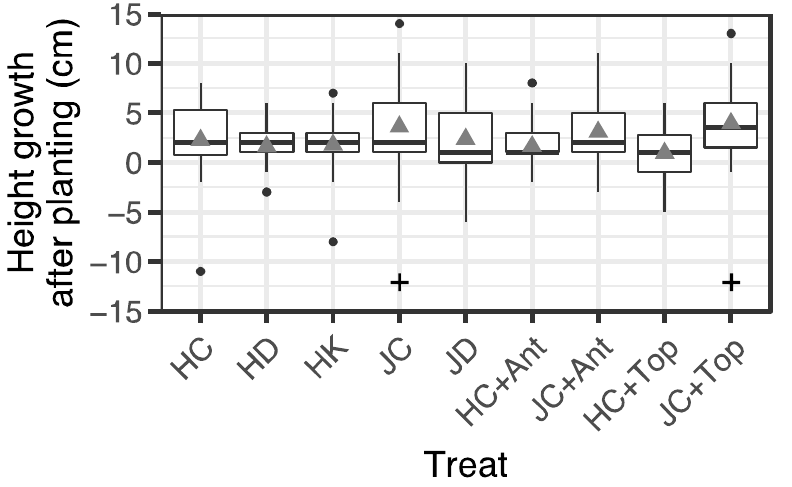
Figure 5. Boxplot with the mean value (gray triangle, n = 17–29) of height growth during three